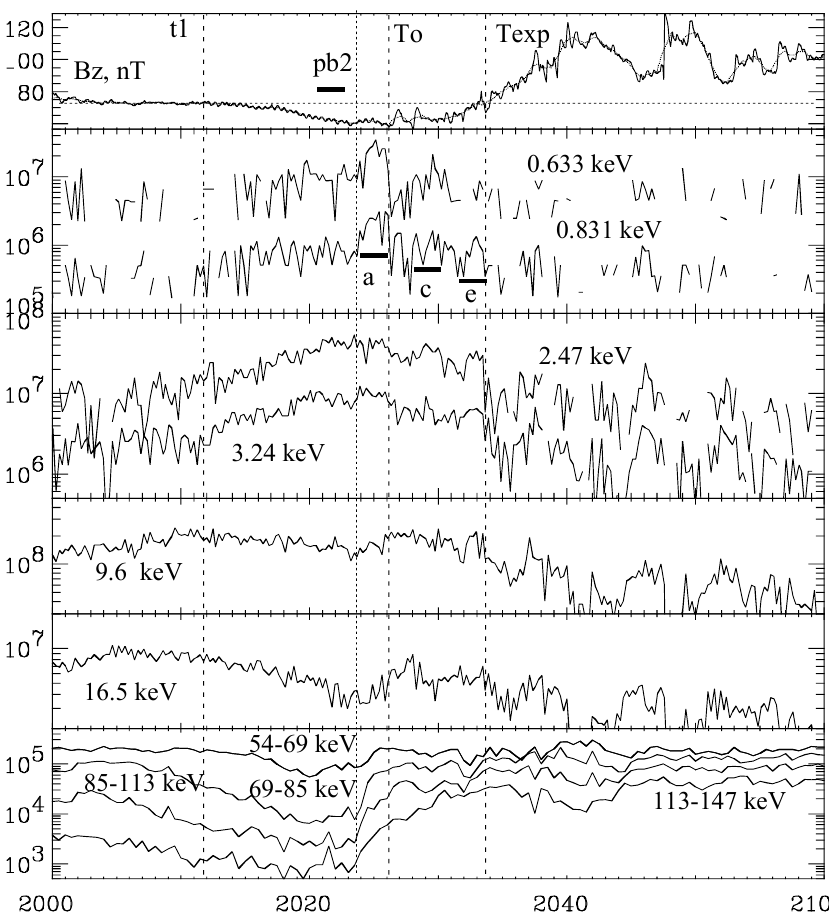
Fig. 4. Substorm on 12 March 1991. Data from the CRRES satellite. From top to bottom: Z-component of the magnetic field; the “A” and “B” populations of LEPA ions with pitch-angles ∼ 90 ◦ are shown in panels (2–3) and (4–5), respectively; flux of high-energy (EPAS) ions with pitch-angles ∼ 90 ◦ are presented in panel 6. Ion flux is in cm − 2 s − 1 sr − 1 keV − 1